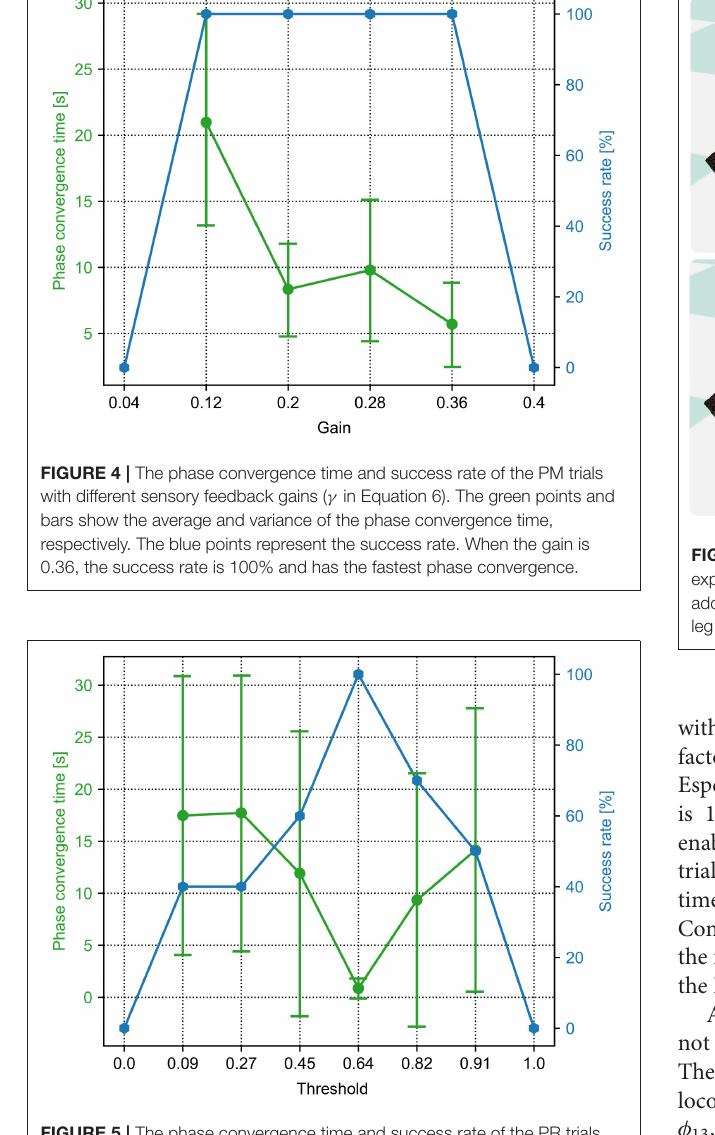
FIGURE 5 | The phase convergence time and success rate of the PR trials with different force threshold factors ( F t in Equation 6). The green points and bars show the average and variance of the phase convergence time, respectively. The blue points represent the success rate. When the threshold factor is 0.64, the success rate is 100% and has the fastest phase convergence.